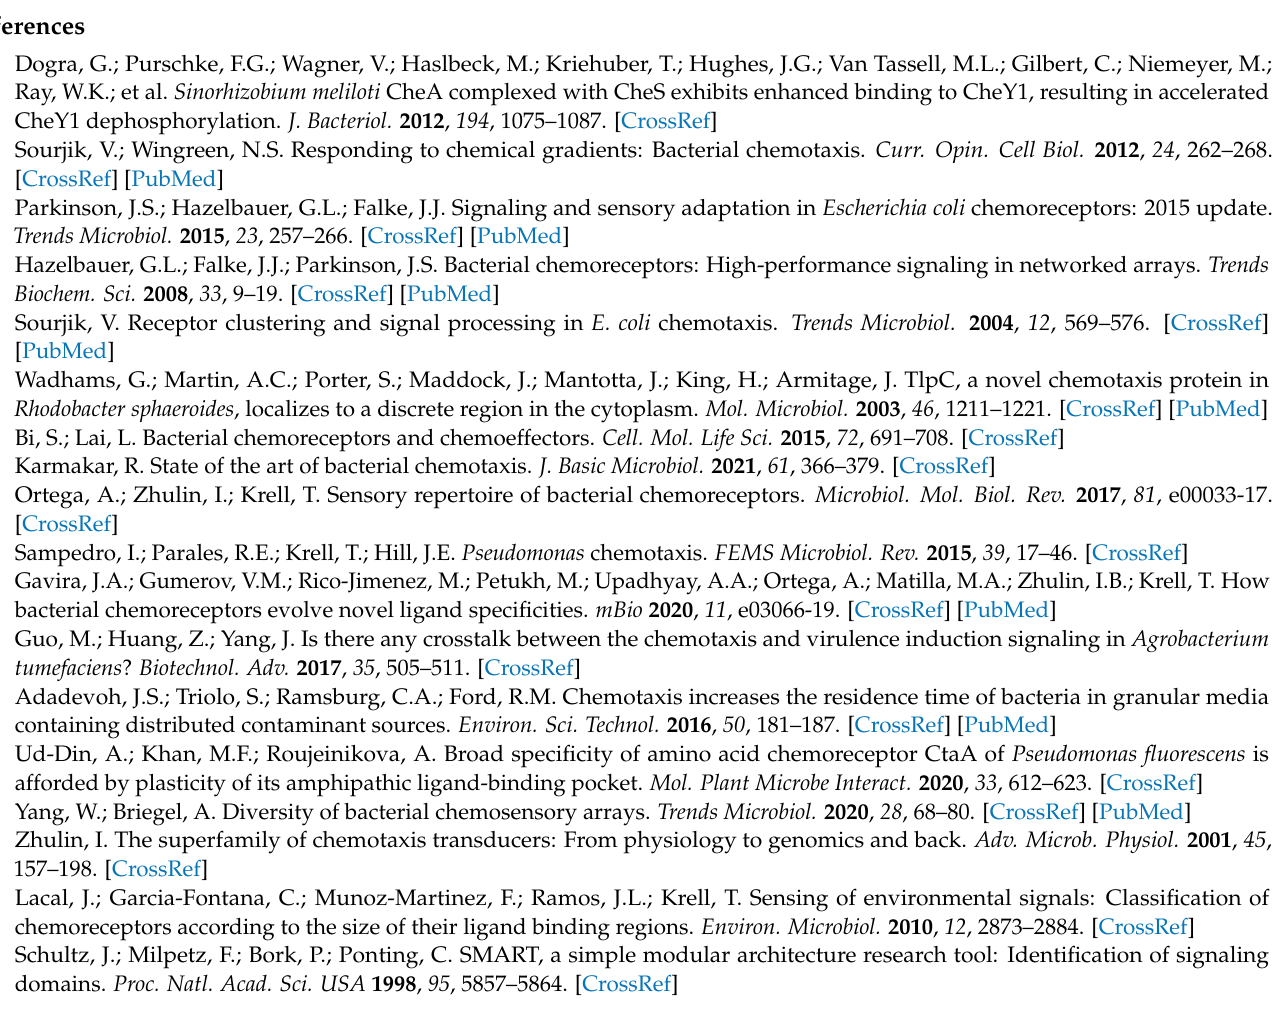
coli MCPs. Table S1: Bacterial strains and plasmids used in this study. Table S2: Primers used in this